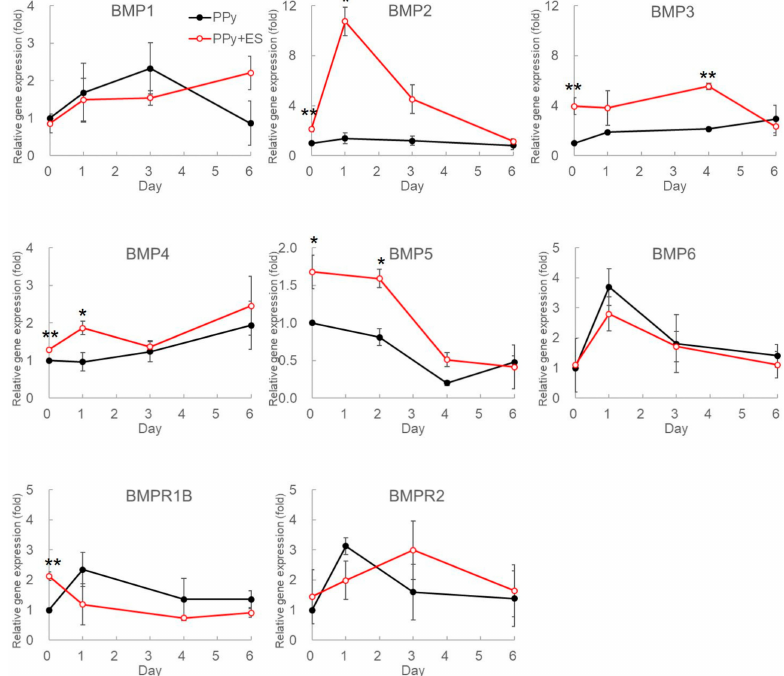
Figure 3. Gene expressions of bone morphogenesis proteins (BMPs) and BMP receptors family in osteogenesis-induced hDPSCs under ES. To determine the ES e ff ects on gene expressions during osteo-di ff erentiation, hDPSCs were seeded to PPy films for 1 day and then were induced by osteogenic medium. In the same time, one-time DCEF treatment was performed for 4 h to stimulate cells immediately after medium replacement (day 0). The mRNAs were harvested from di ff erentiated hDPSCs on di ff erent days, and the transcriptional levels of BMP family were determined using quantitative real-time PCR (qPCR). All relative results were compared to those from undi ff erentiated hDPSCs, and the red and black circles represent the relative gene expression levels of hDPSCs with or without DCEF treatment, respectively. Each value is the average ± SD of three independent experiments ( n = 3; *: p < 0.05, **: p <